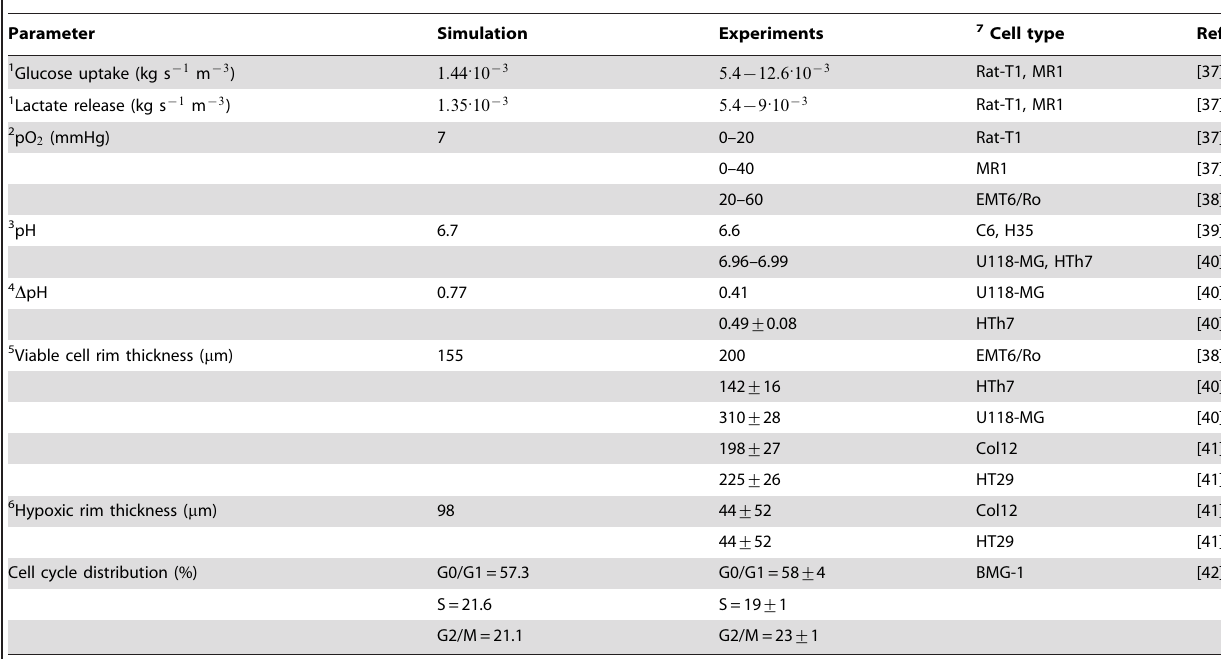
Table 1. Comparisons with experimental